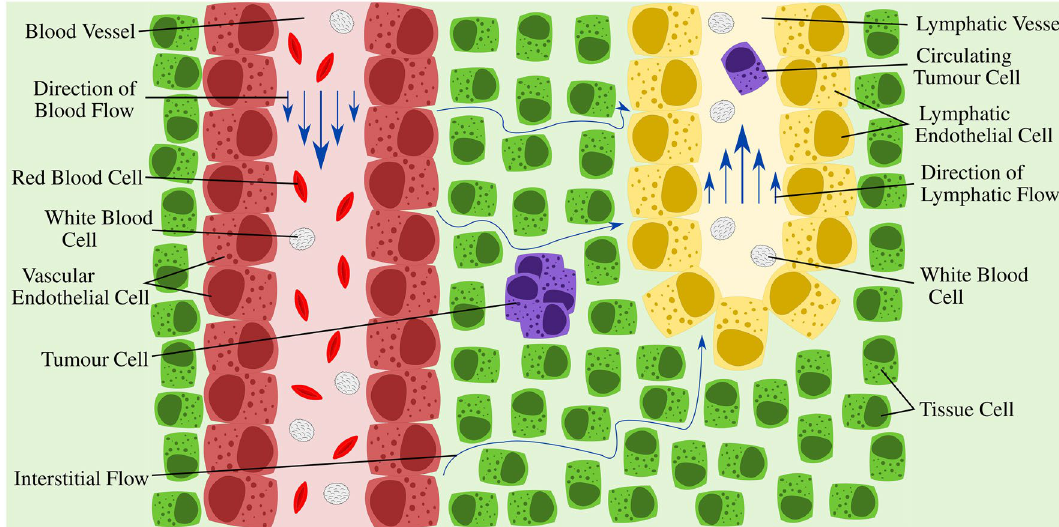
Figure 1. Different flow regimes in the body. High-velocity fluid exits the blood vessels, surrounding the normally static tissue cells, and progressing slowly in the direction of the lymphatic vessels. This is known as interstitial flow. Excess fluid is collected by the lymphatic vessels and returned to the blood. Fluid flow direction is indicated by the blue arrows. Figure was created using Inkscape 31